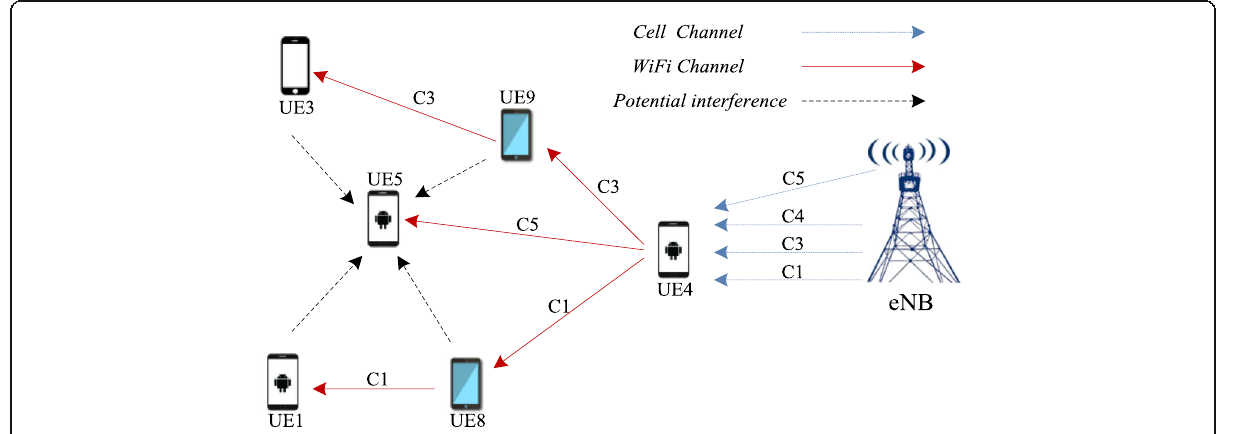
Fig. 2 Interface and interference in outband D2D